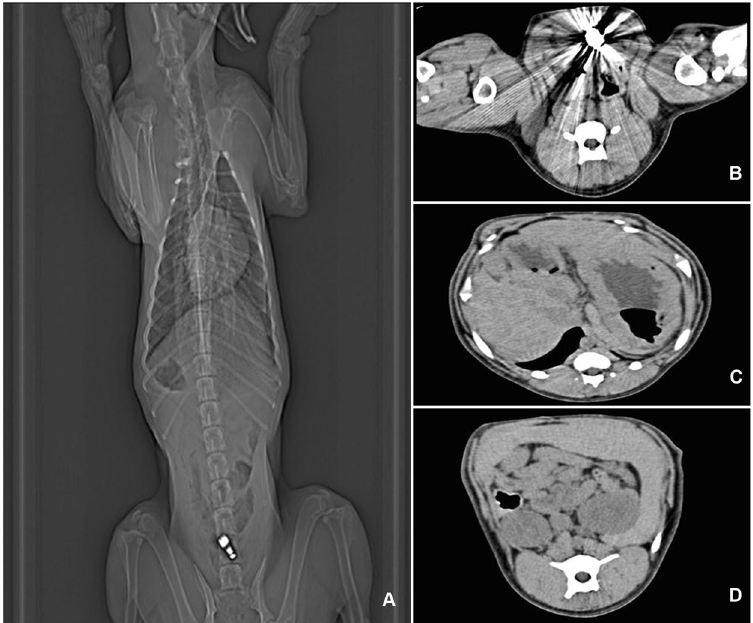
Figure 1. Radiographic examinations after administration of ultra-high frequency capsules. ( A ) Abdominal plain film after 2 hours’ vibration at ultra-high frequency. ( B ) CT image of stomach (arrow showing VC in the stomach). ( C ) CT image of intestine. ( D ) CT image of